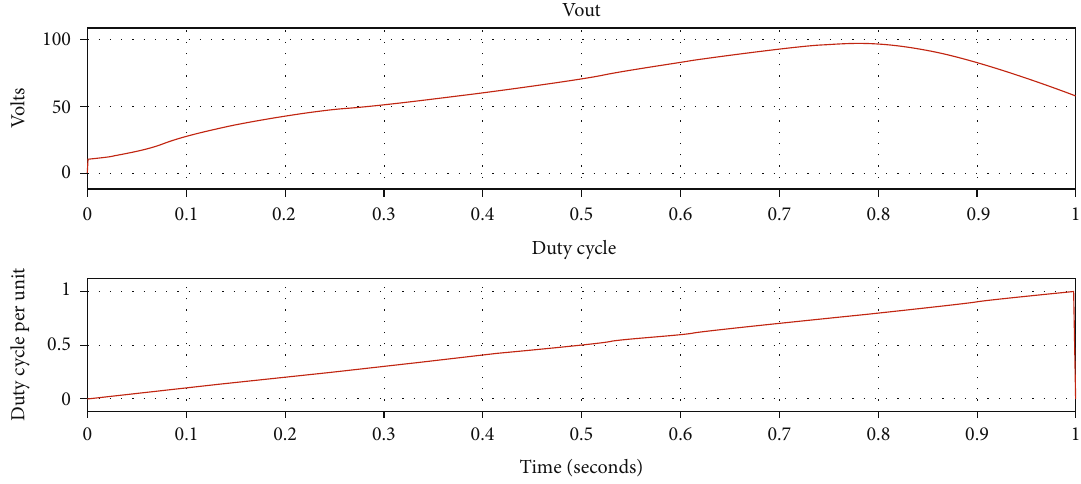
Figure 3: Plot of the output voltage vs. duty cycle changed from 0 to